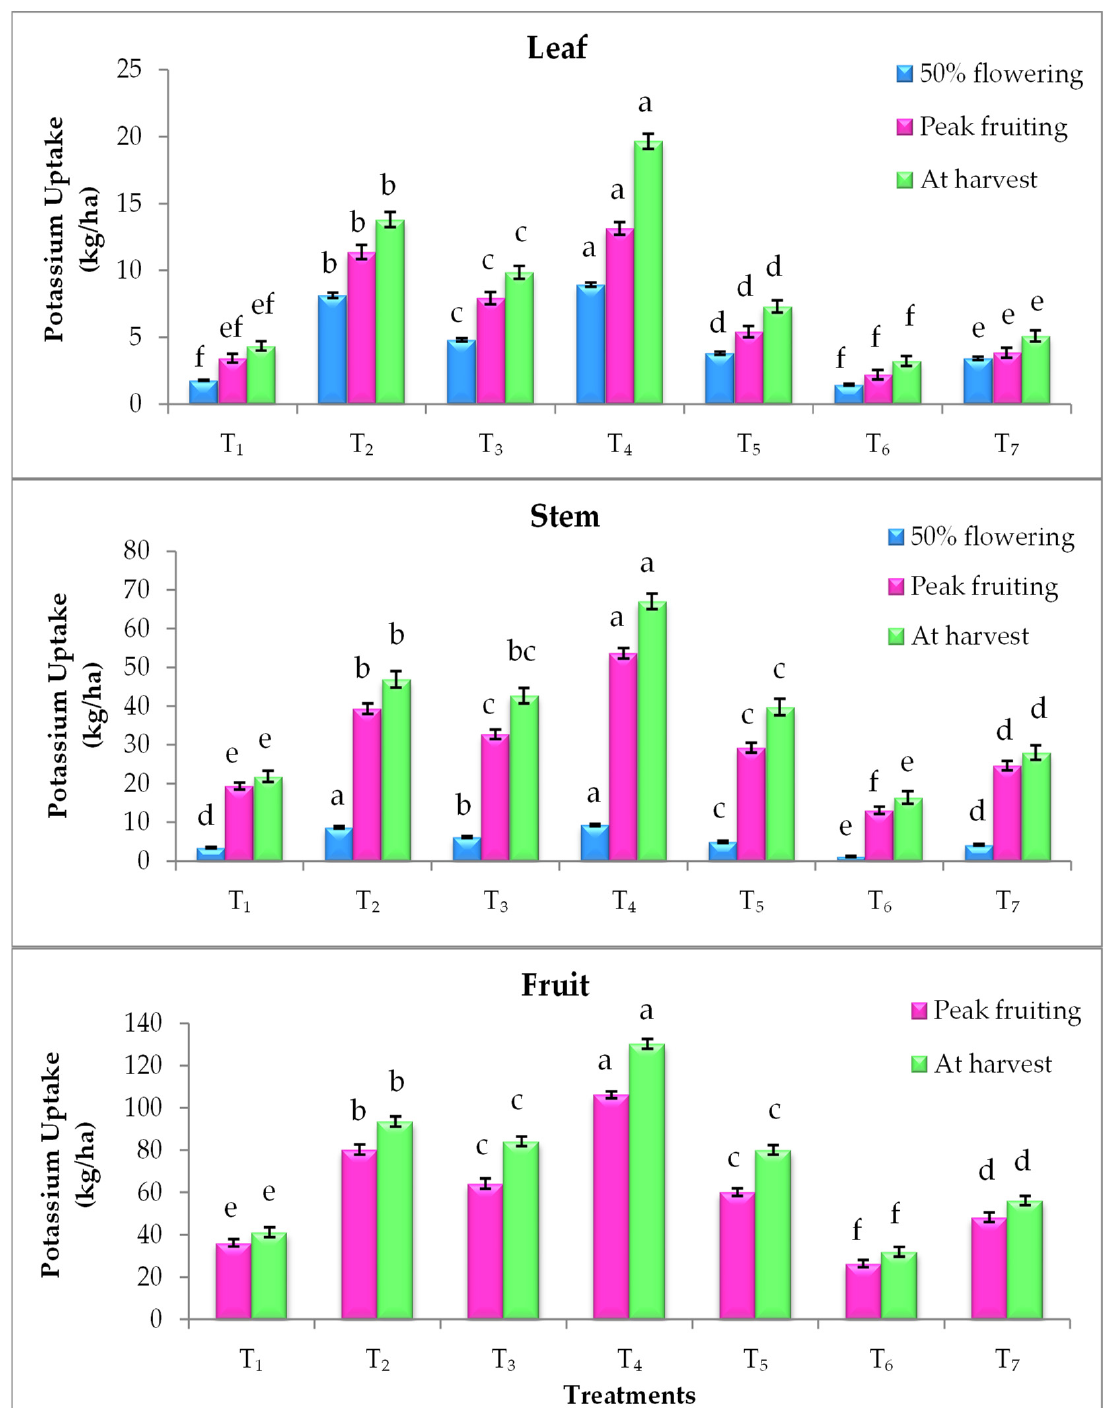
Figure 3 . Potassium uptake by leaf, stem and fruit of tomato plants as influenced by elevated CO 2 and temperature at 50% flowering, peak fruiting and at harvest stages ( n = 15). Note: According to DMRT, values with same alphabet(s) do not differ statistically at the 0.05 level; Refer Table 1 for the description of the treatments.